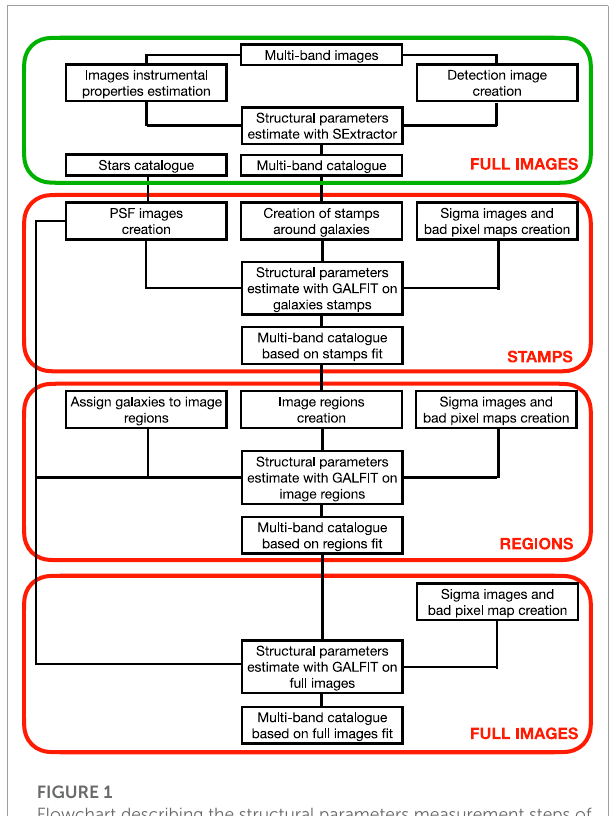
FIGURE 1 Flowchart describing the structural parameters measurement steps of the pipeline adopted in LT18 and LT23. The red boxes refer to estimates using GALFIT , while the green box using SEXTRACTOR .